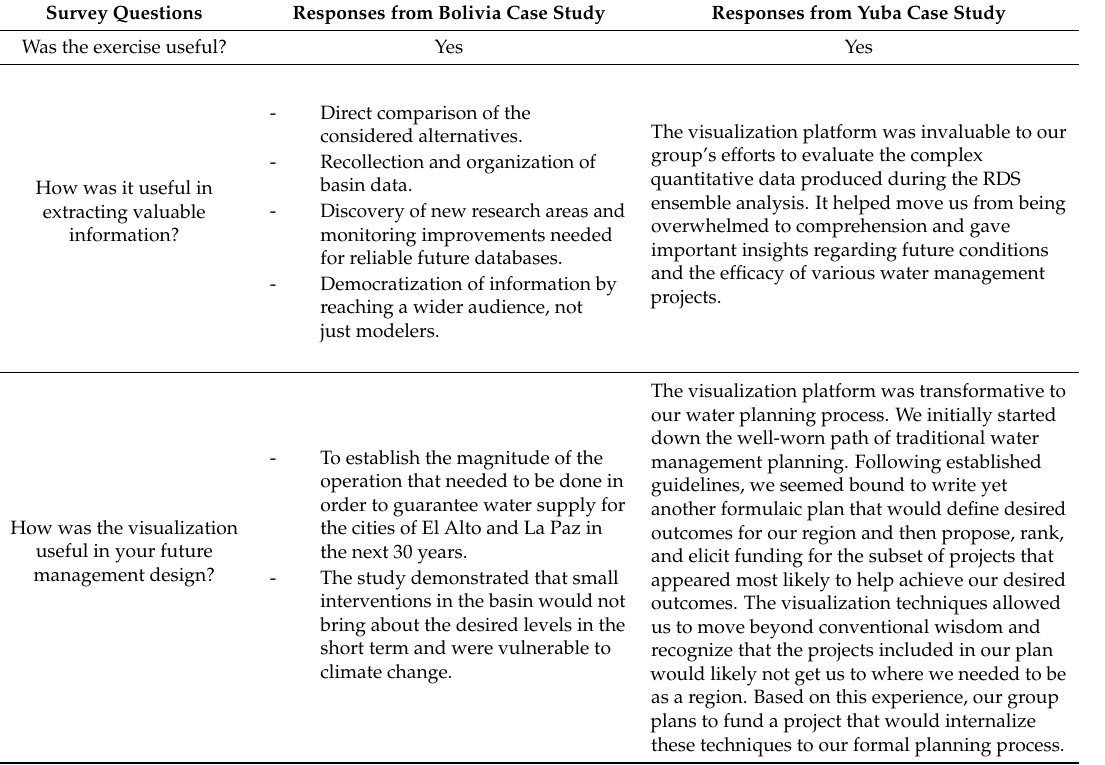
Table 3. Some observations on the utility of the RDS practice from a survey of participants following the completion of the exercise in both La Paz/El Alto, Bolivia and Yuba County,